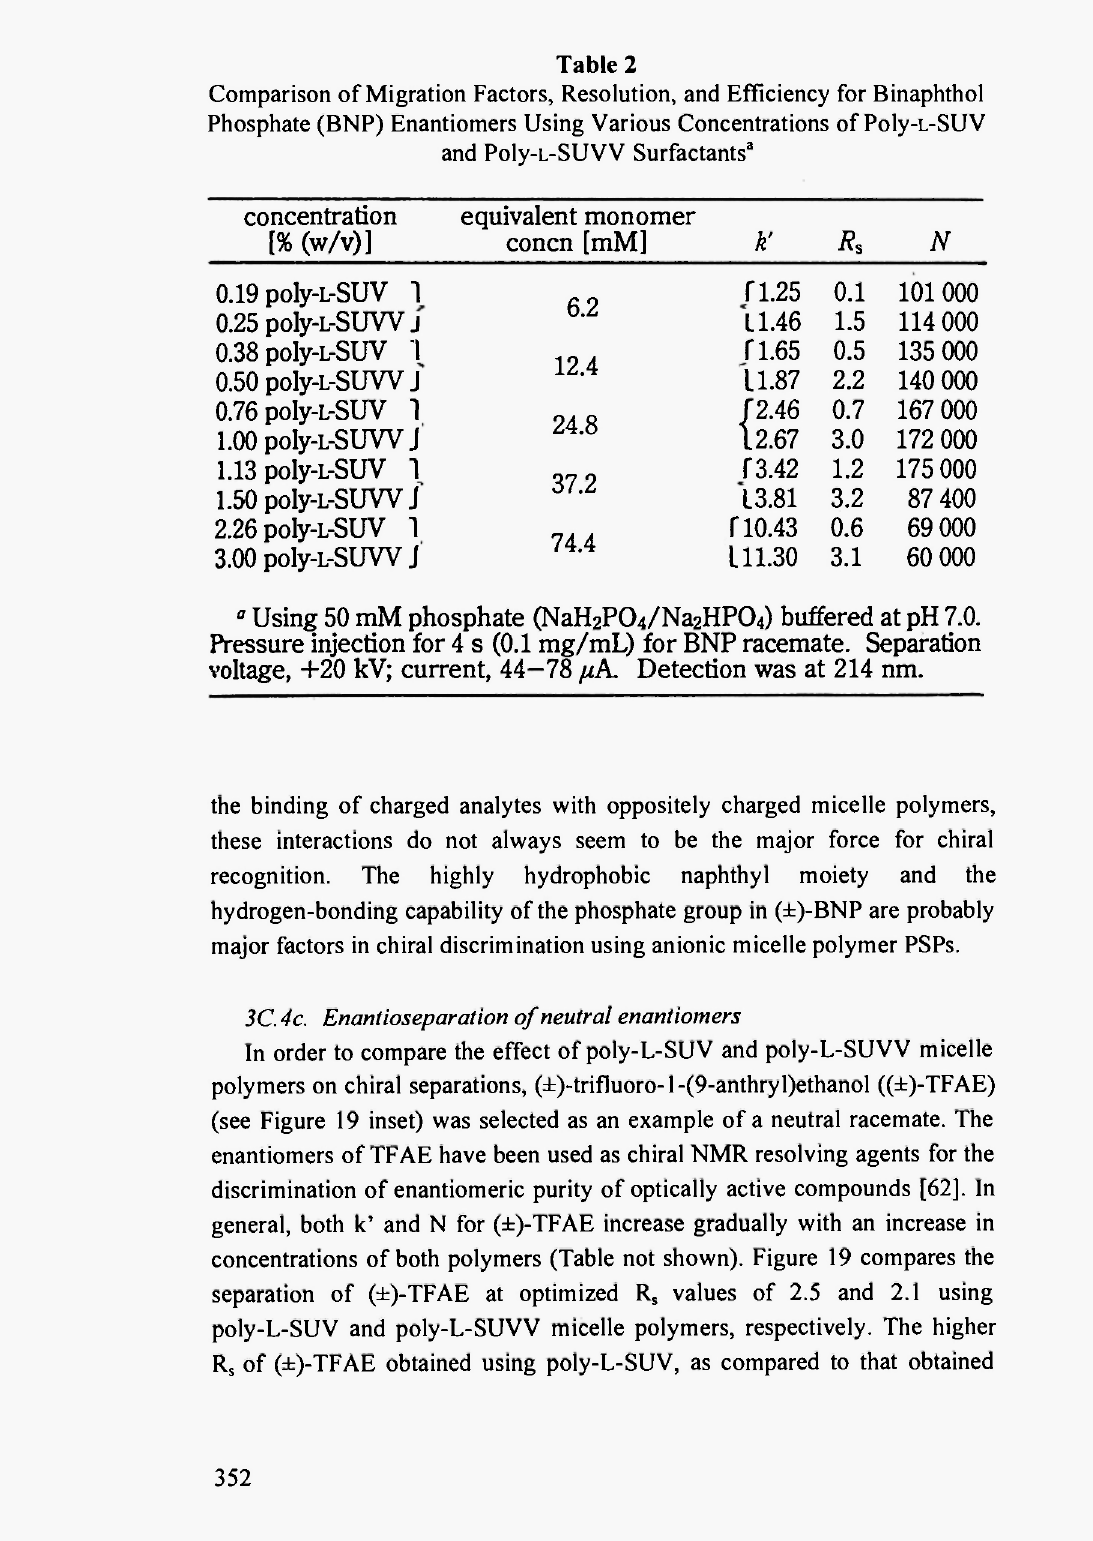
Comparison of Migration Factors, Resolution, and Efficiency for Binaphthol Phosphate (BNP) Enantiomers Using Various Concentrations of Poly-L-SUV and Poly-L-SUVV Surfactants